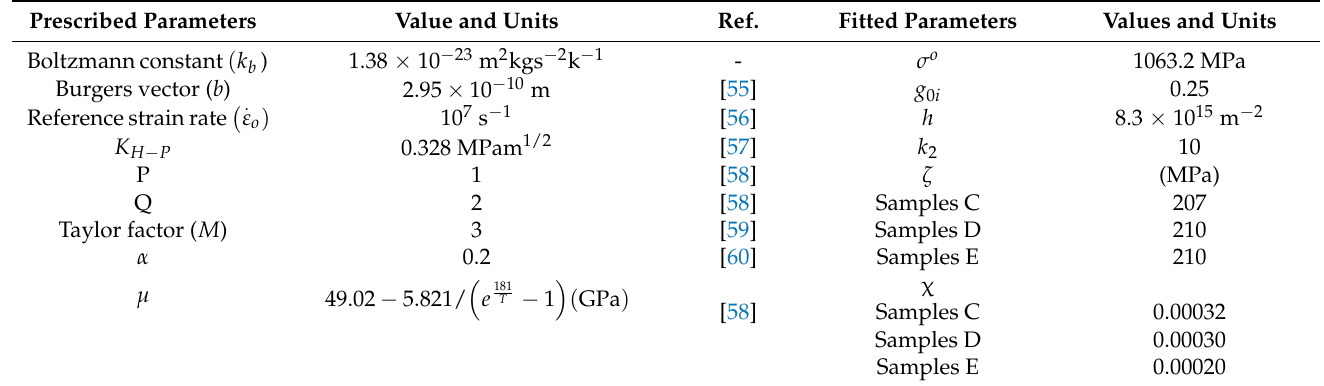
Table 3. Calibrated model input parameters and other constants obtained from the